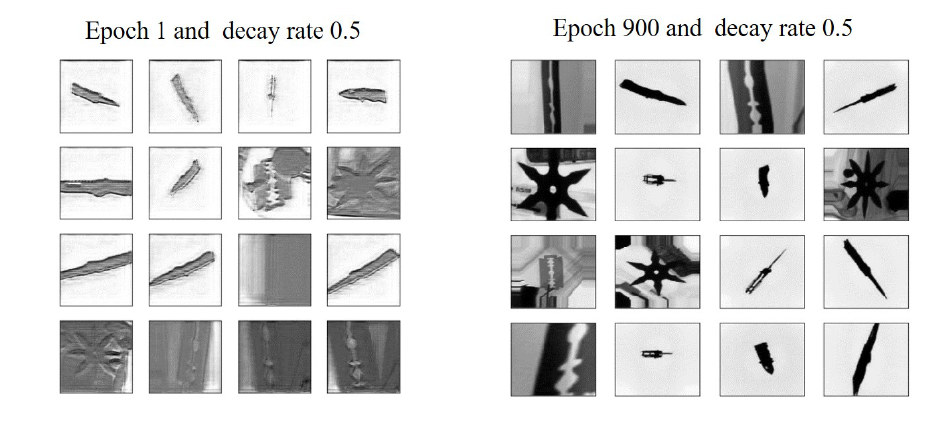
Figure 13. Generated images of learning rate with decay rate